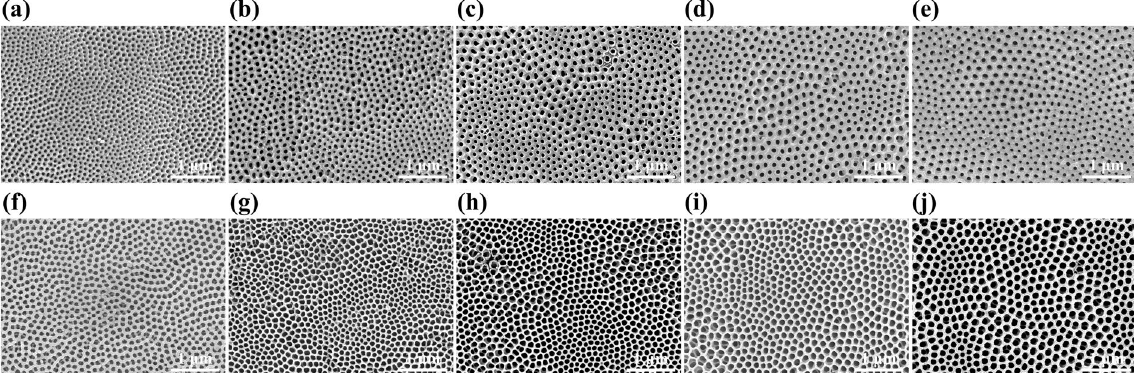
Figure 1. Top-view SEM images of TiO 2 nanotube arrays anodized at 60 V for 1 hour in ethylene glycol containing (a–e) 2, 4, 6, 8, 10 vol% distilled water with 0.2 wt% NH 4 F and (f–j) 2, 4, 6, 8, 10 vol% distilled water with 0.4 wt% NH 4